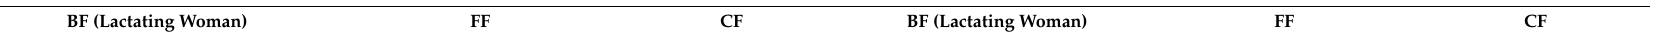
Table 5. Practical recommendations for infant feeding during the first year of life according to vegetarian or vegan regimens (sources: Lemale et al. [8] and Mangels et al. [11]). Vegetarian Diet Vegan Diet BF (Lactating Woman) FF CF BF (Lactating Woman) FF